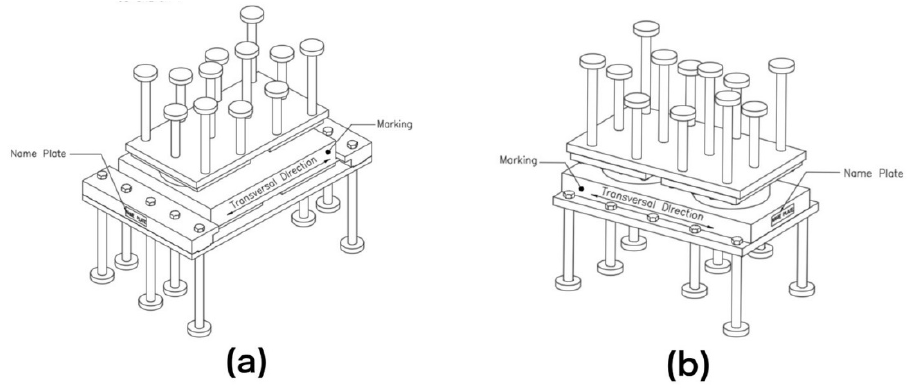
Figure 7. Details of bearing: ( a ) fixed bearing and ( b ) free